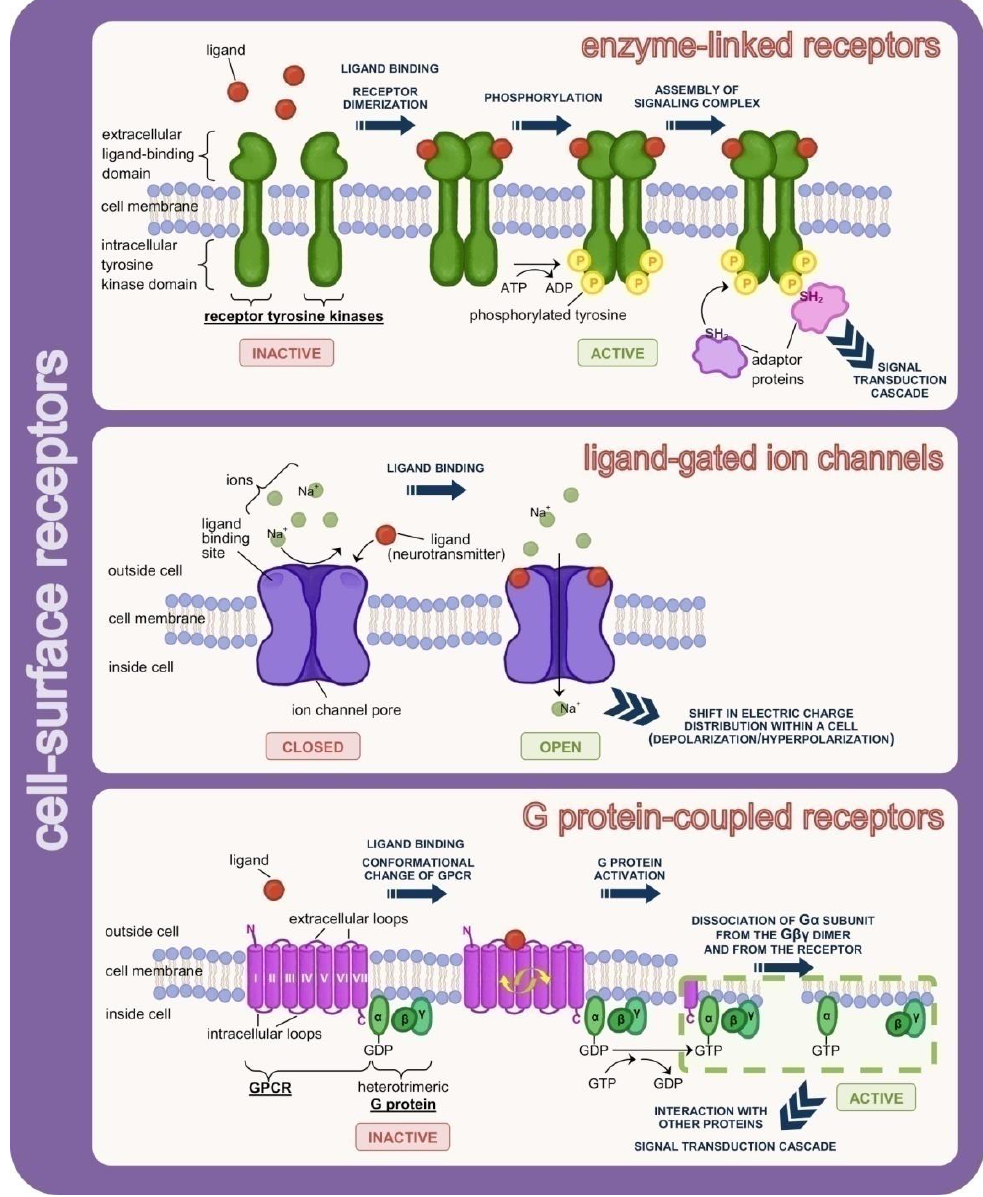
Figure 3. Cell surface receptors embedded in the cell membrane. They act by ligand binding to the extracellular domain of the receptor. The intracellular (cytoplasmic) domain of the receptor communicates via interactions with effector proteins.